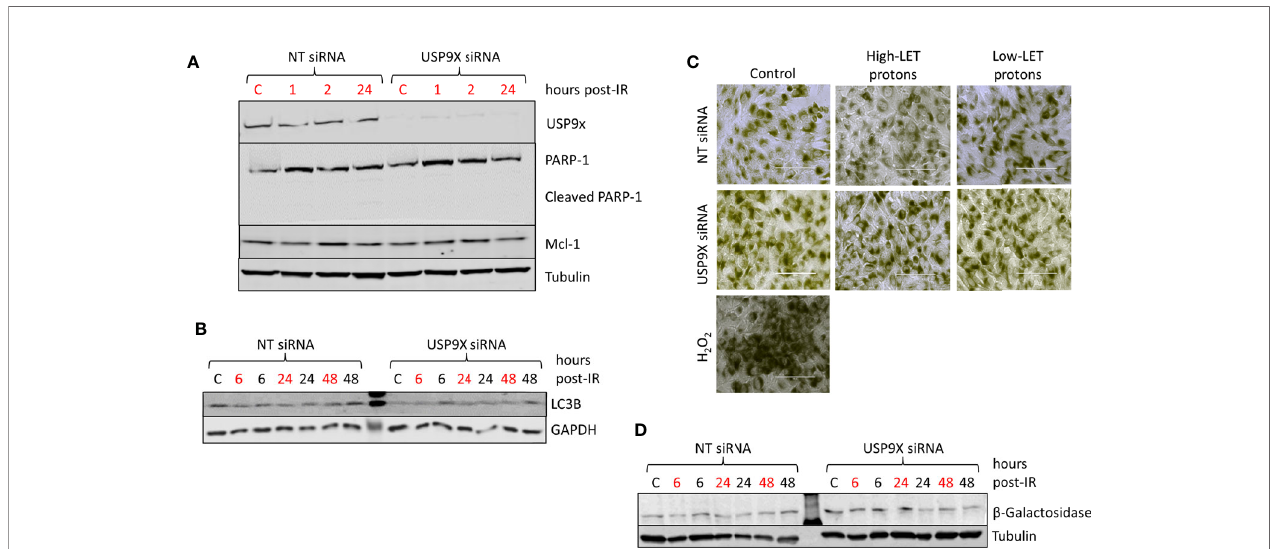
FIGURE 5 | USP9X depletion does not affect cellular levels of apoptosis, autophagy and senescence in response to relatively high-LET protons. HeLa cells were treated with USP9X or a non-targeting (NT) control siRNA for 48 h, and unirradiated (designated C) or irradiated with 4 Gy relatively high-LET or low-LET protons and allowed to repair for the time points indicated post-irradiation. (A, B, D) Whole cell extracts were analyzed by immunoblotting using the indicated antibodies. (C) Cells were fi xed 48 h post-irradiation and stained for b -Galactosidase, with 100 µM H 2 O 2 used as a positive